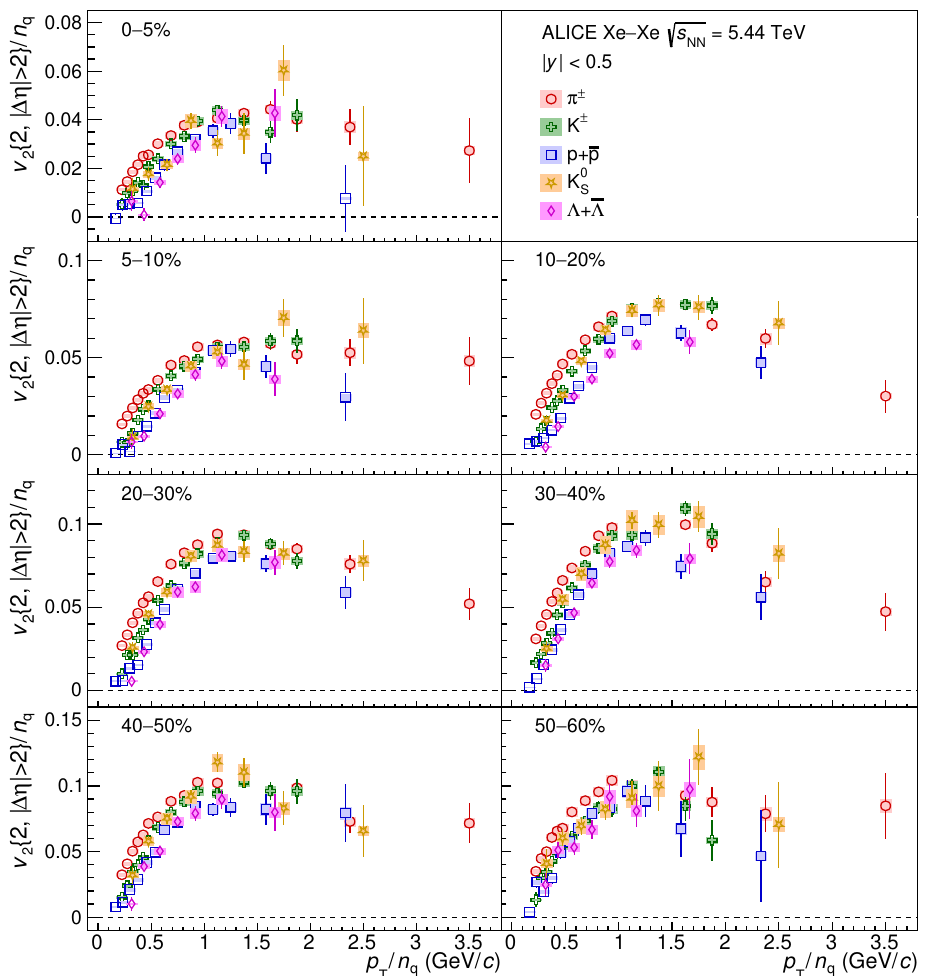
Figure 6. The p T /n q dependence of v 2 /n q of π ± , K ± , p+ p , K 0 classes. Bars (boxes) denote statistical (systematic)